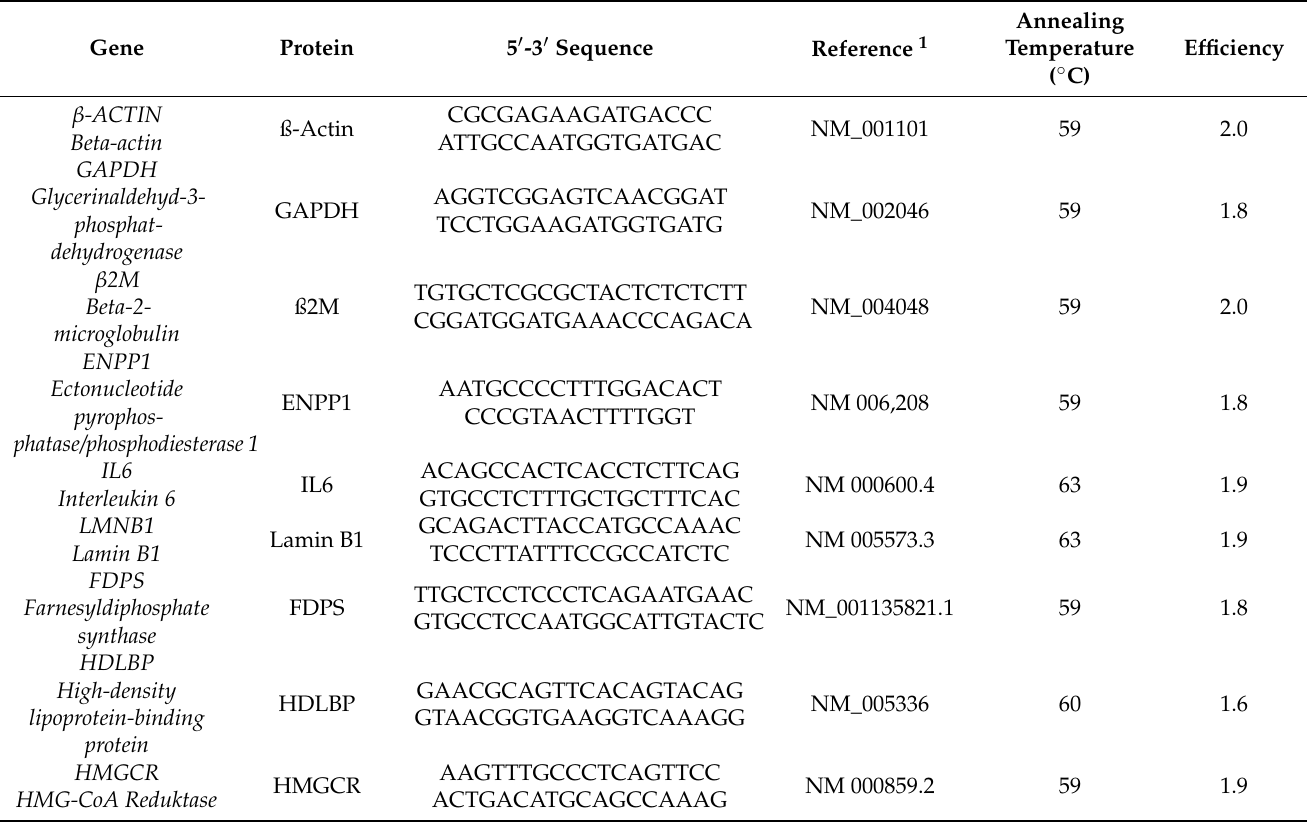
Table 2. Primer sequences used for quantitative real-time